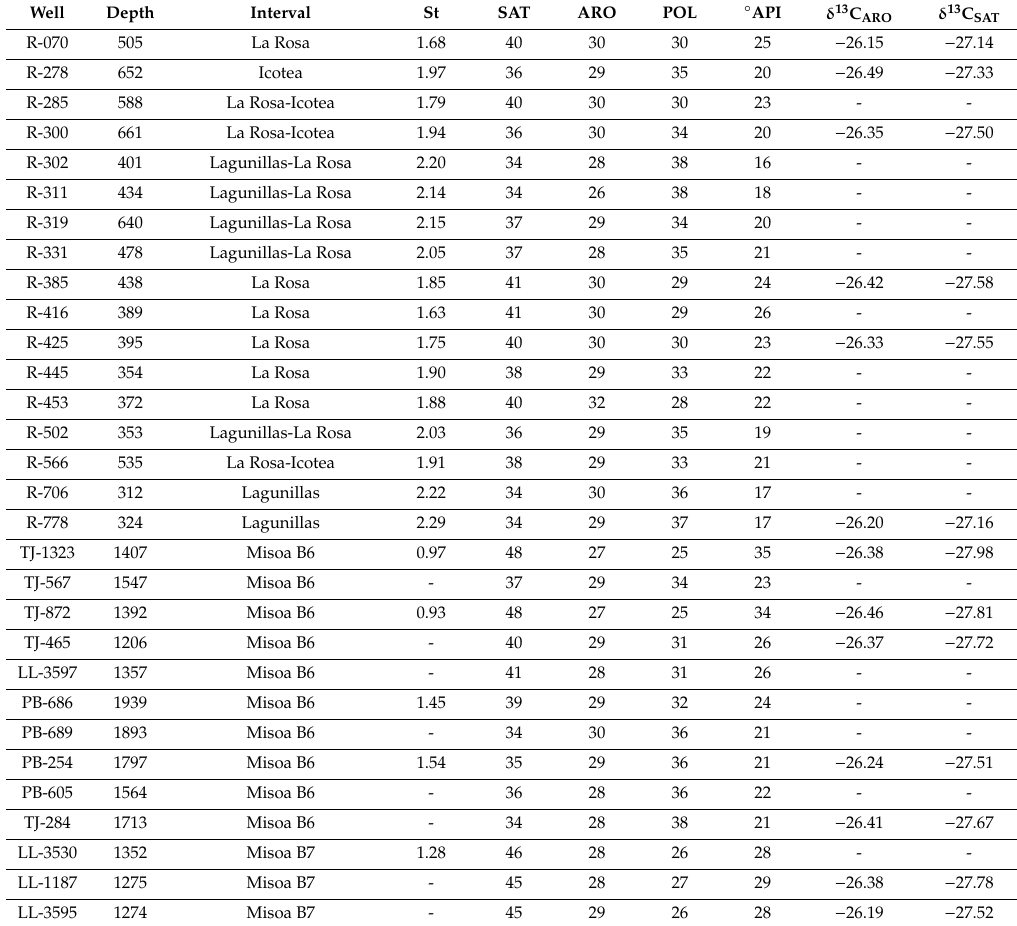
Table 1. Reservoir names, depths, bulk composition, API gravities, sulfur contents (wt.%), and δ 13 C data (% (cid:24) ) of the aromatic and saturated hydrocarbons (wt.%) of the oils analyzed.